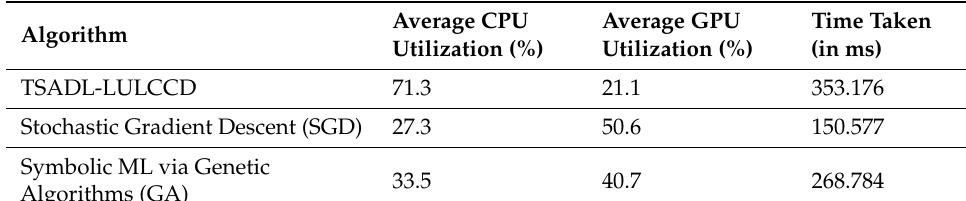
Table 4. Time Comparison between KNN, LSH with TRT, LSH without TRT Models.